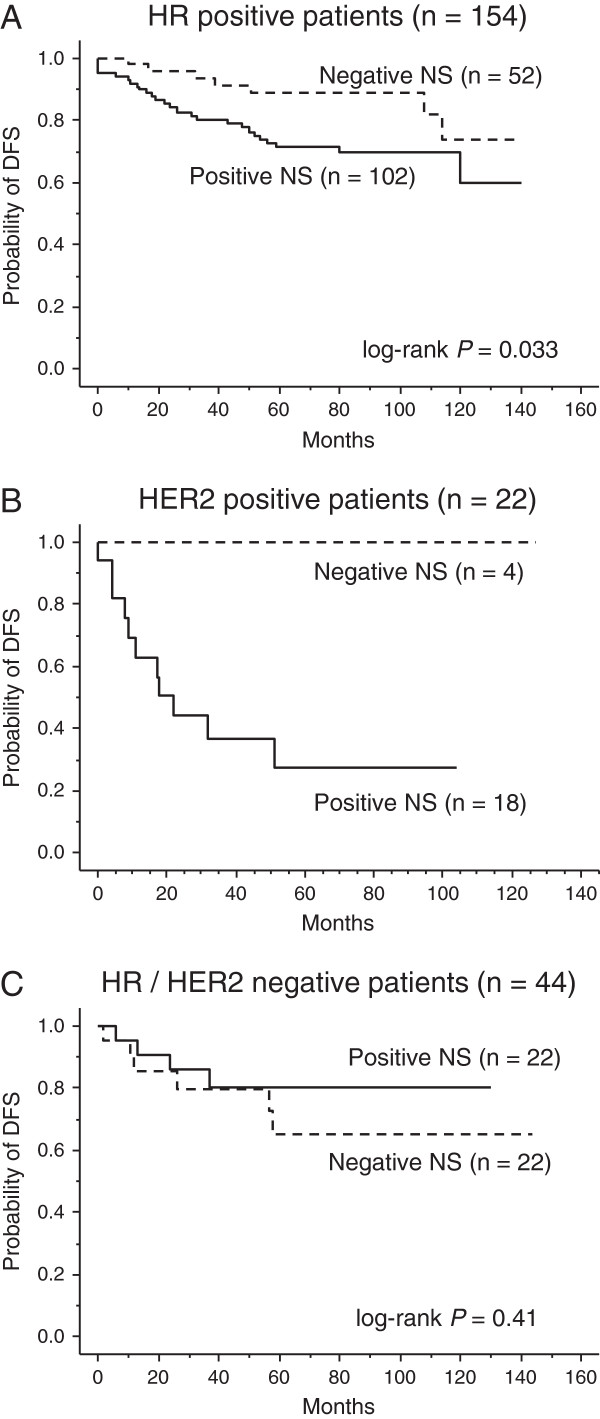
Prognostic impact of NS status in the three subgroups of the different biological subtype tumors: luminal-type tumors, HER2-type tumors, and triple-negative tumors. A. Subgroup analysis of the 154 patients with luminal-type tumors (HR-positive tumors). Two disease-free survival (DFS) curves, that for the 102 patients with NS-positive tumors and that for the 52 patients with NS negative tumors, differ significantly (P = 0.033). B. Subgroup analysis of the 22 patients with HER2-type tumors (HER2-positive and HR-negative tumors). In two disease-free survival (DFS) curves, that for the 18 patients with NS-positive tumors and that for the 4 patients with NS-negative tumors, five-year DFS rates differ largely (100% vs 28%). P-value was not available because there was no relapse in the patients with NS-negative tumors. C. Subgroup analysis of the 44 patients with triple-negative tumors (HR and HER2 negative tumors). The two curves do not differ significantly (P = 0.41).